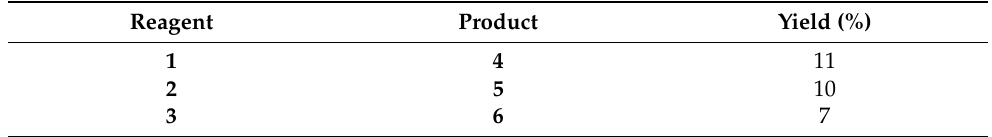
Table 2. Synthesis of KuQuinone diethyl phosphonate derivatives. Reaction conditions: 5.75 mmol of 2-hydroxy-1,4-naphthoquinone, 12 mmol of bromoalkylphosphonate, 8 mmol of Cs 2 CO 3 , 0.33 mmol of FcH, in 22 mL of DMSO, at 114 ◦ C, for 41